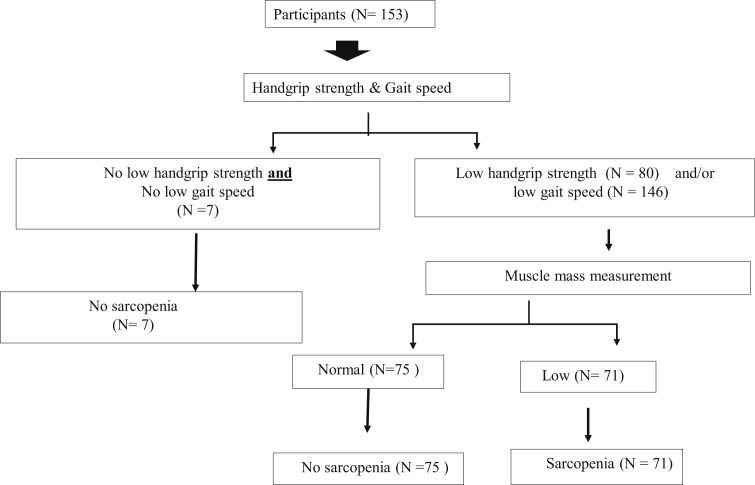
Sarcopenia category by diagnostic algorithms of Asian Working Group for Sarcopenia at post-operative open heart surgery.